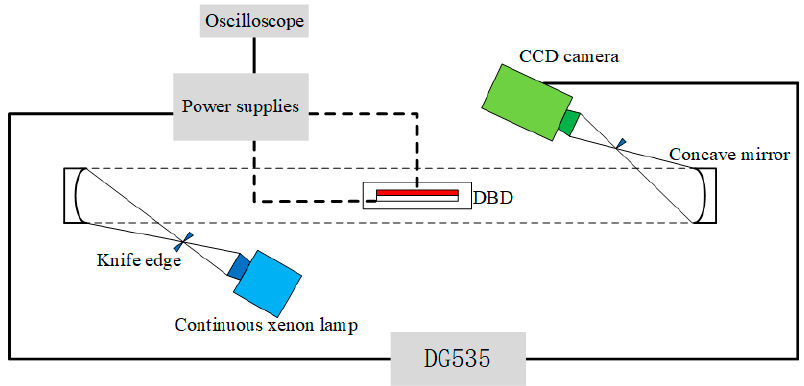
Figure 5. Schlieren imaging system.